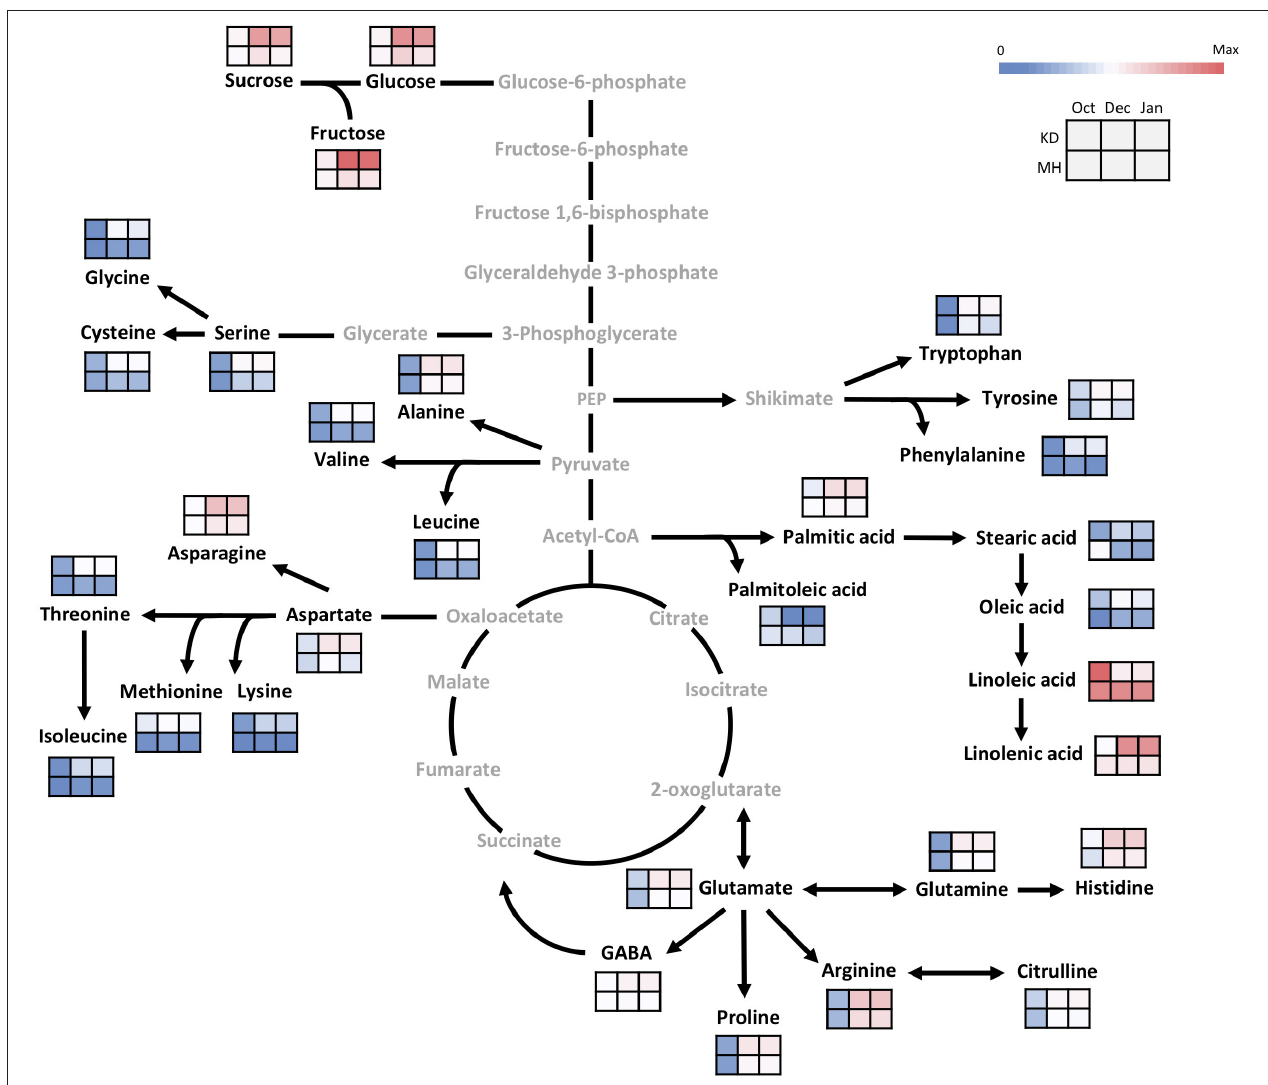
FIGURE 5 | Changes in the primary metabolism in the stem of KD and MH during the hardening process from October to January. Quantified metabolites are set in black and non-measured metabolites are set in gray color. Each heat map represents the intensity of the corresponding metabolite at three time-points (October, December, and January) of hardy (KD) and sensitive (MH) genotypes; October (control or pre-hardening stage), December, and January (hardening